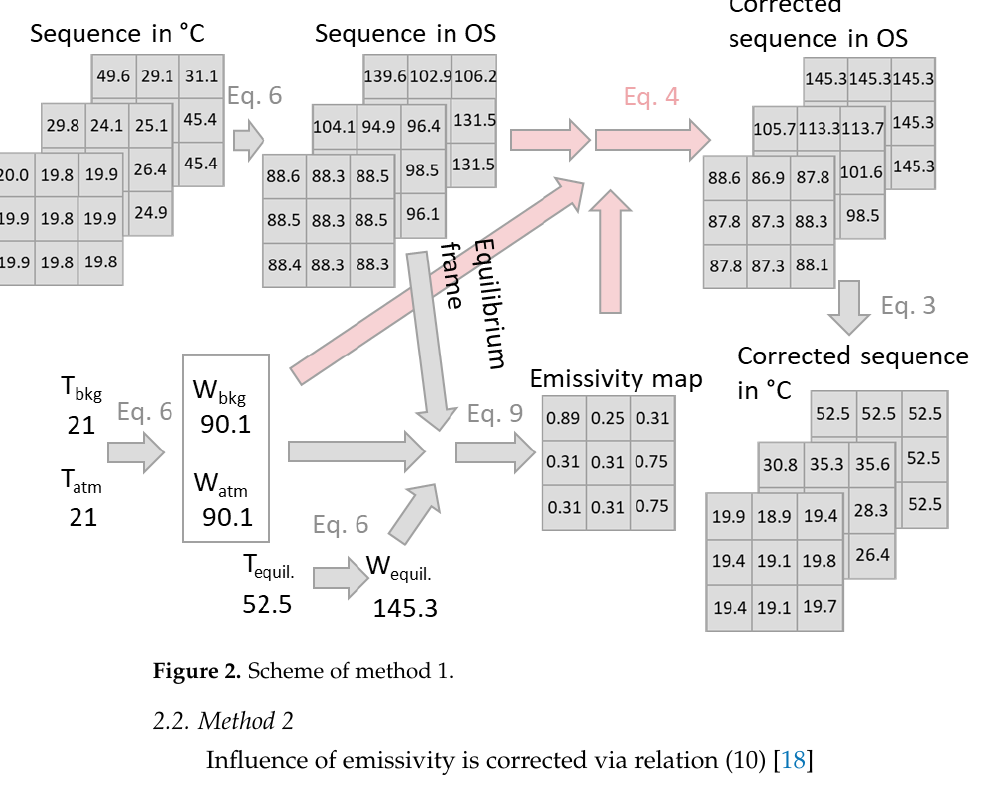
Figure 2. Scheme of method